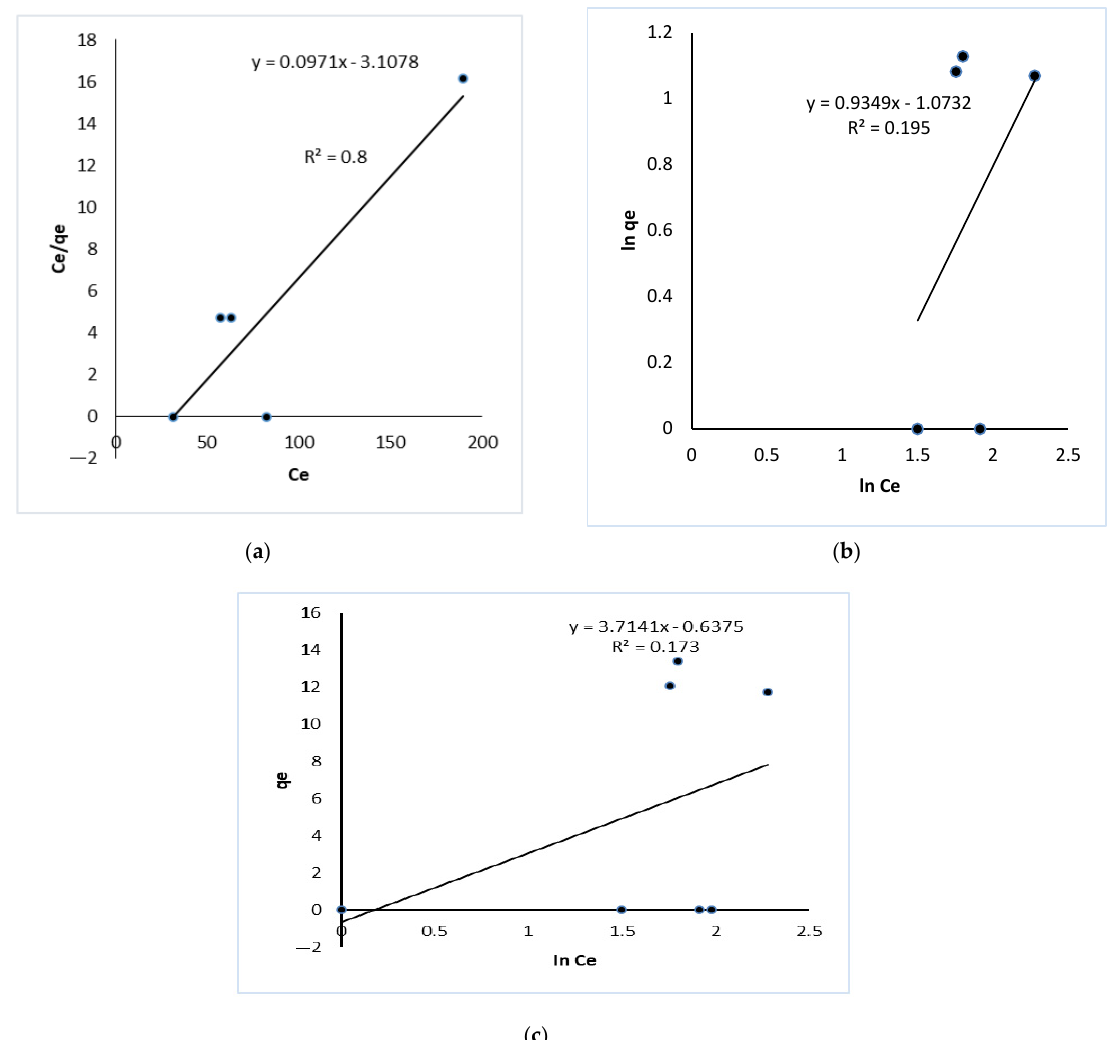
Figure 5. ( a ) Langmuir, ( b ) Freundlich, and ( c ) Temkin isotherms for PB dye uptake on PFPB. Table 2. Isotherm constants for PB dye uptake onto pineapple fruit peel biochar. Isotherm